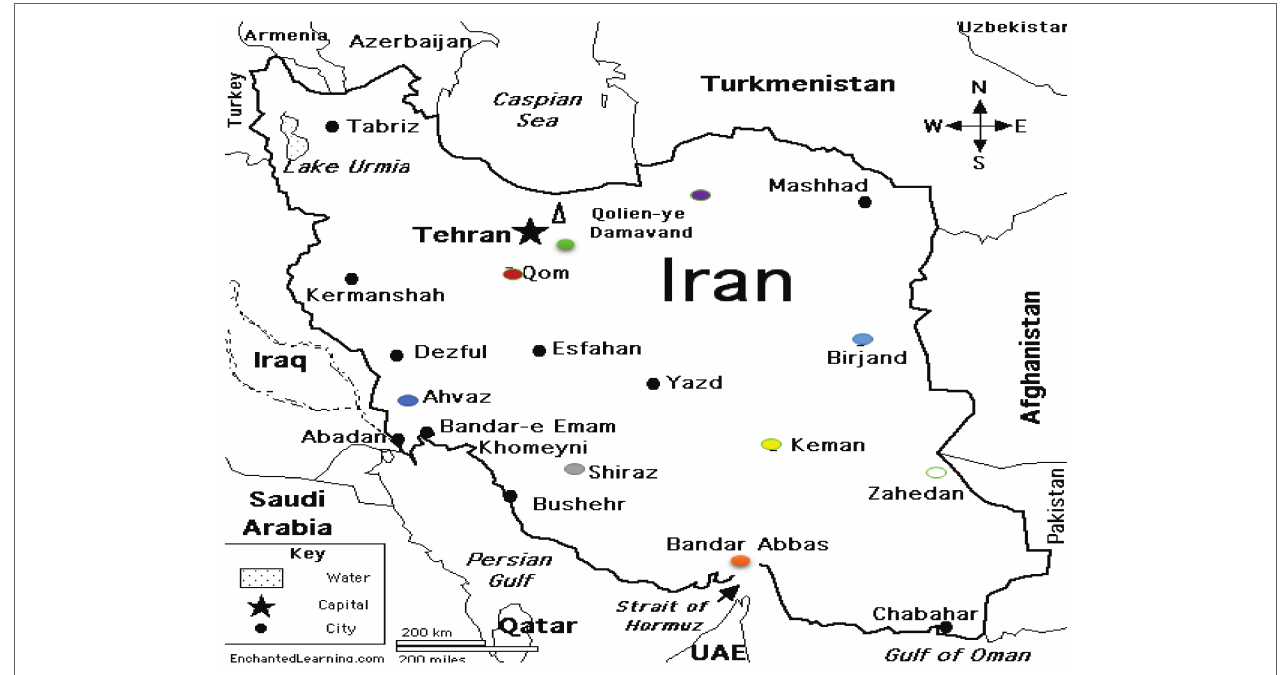
FIGURE 1 | S. maltophilia strains isolated from Iran. 4 isolates from Birjand. 87 isolates from Tehran: Capital of Iran. 32 isolates from Ahwaz. 20 isolates from Shiraz. 14 isolates from Bandar Abbas. 4 isolates from Zahedan. 1 isolate from Kerman. 1 isolate from Gorgan. 1 isolate from Qom.